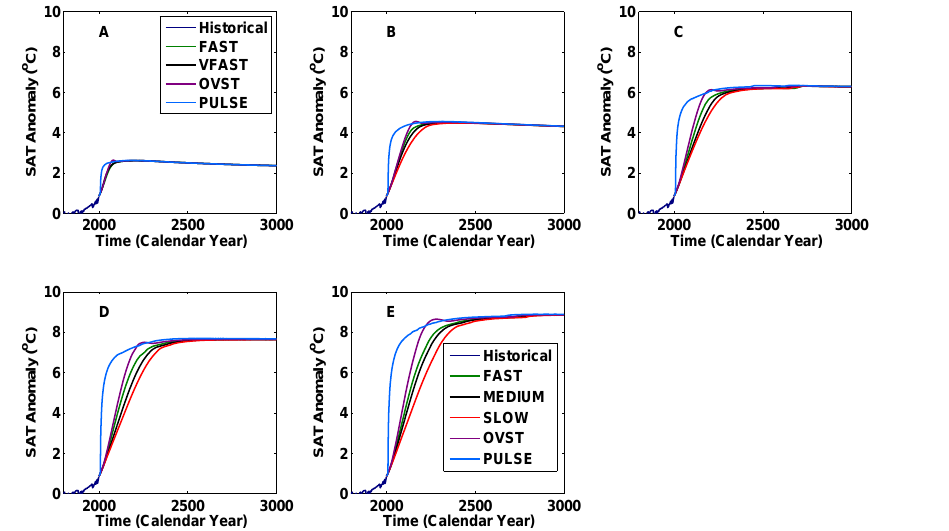
Figure 3. Global mean surface air temperature (SAT) anomaly relative to the year 1800 for the 1275–5275GtC scenarios. (a) 1275GtC scenarios, (b) 2275GtC scenarios, (c) 3275GtC scenarios, (d) 4275GtC scenarios, and (e) 5275GtC scenarios. Note: legend for (e) also applies to (b–d) .